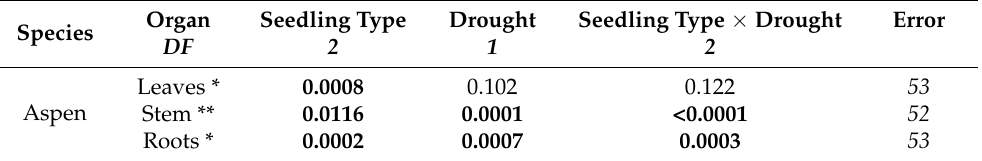
Table 3. Two-way ANOVA summary for effects of seedling type and drought on relative allocation of new structural biomass (%) for aspen. Significant effects ( p ≤ 0.10) are indicated in bold. Species